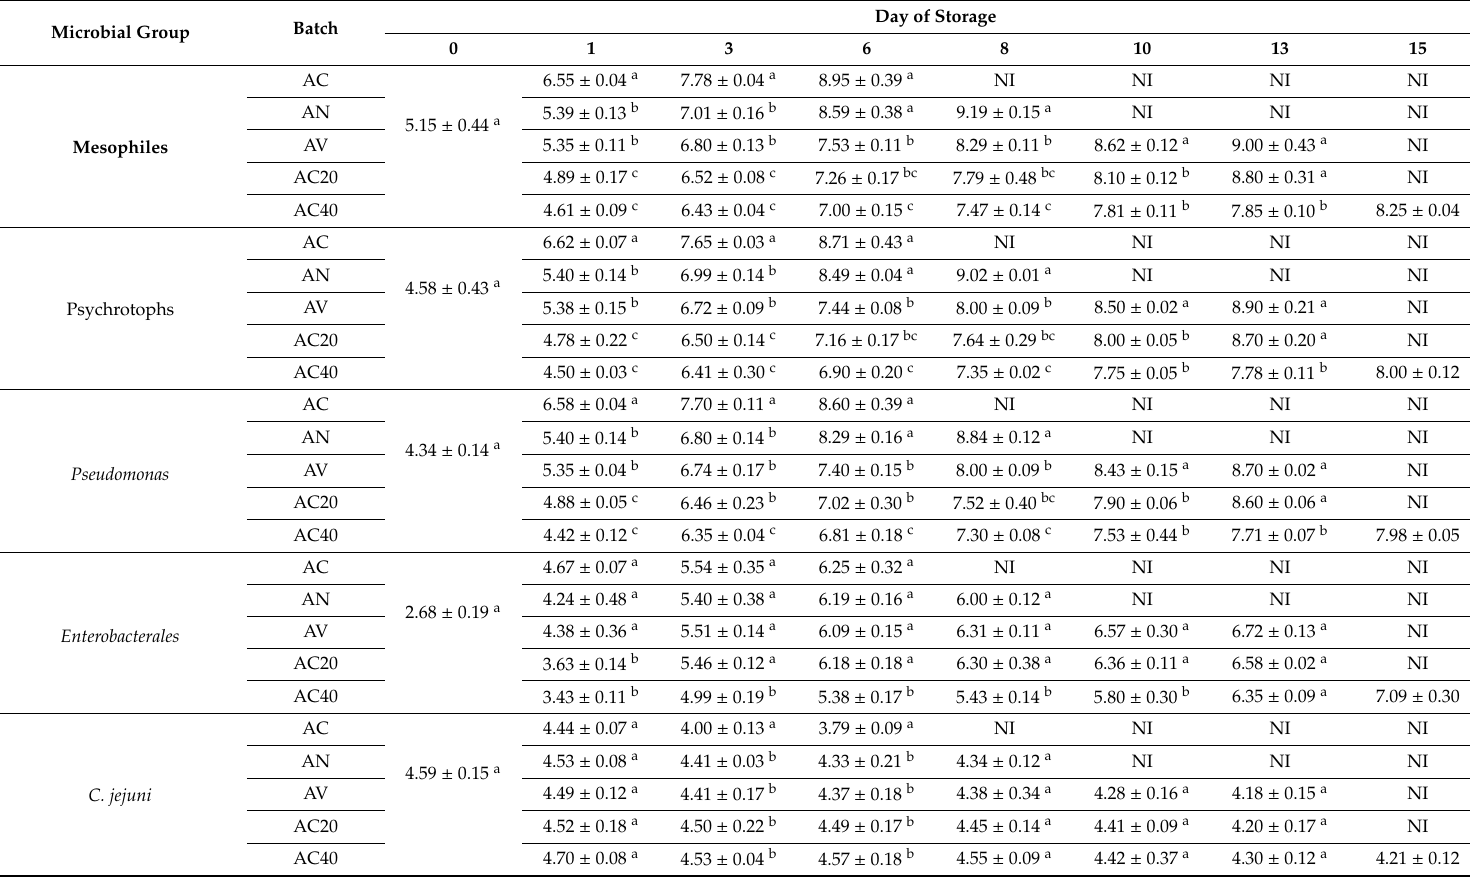
Table 3. E ff ect of di ff erent atmosphere packaging conditions on the mesophilic, psychrotrophic, Pseudomonas, Enterobacterales , and C. jejuni counts on chicken legs (log cfu / g). Microbial